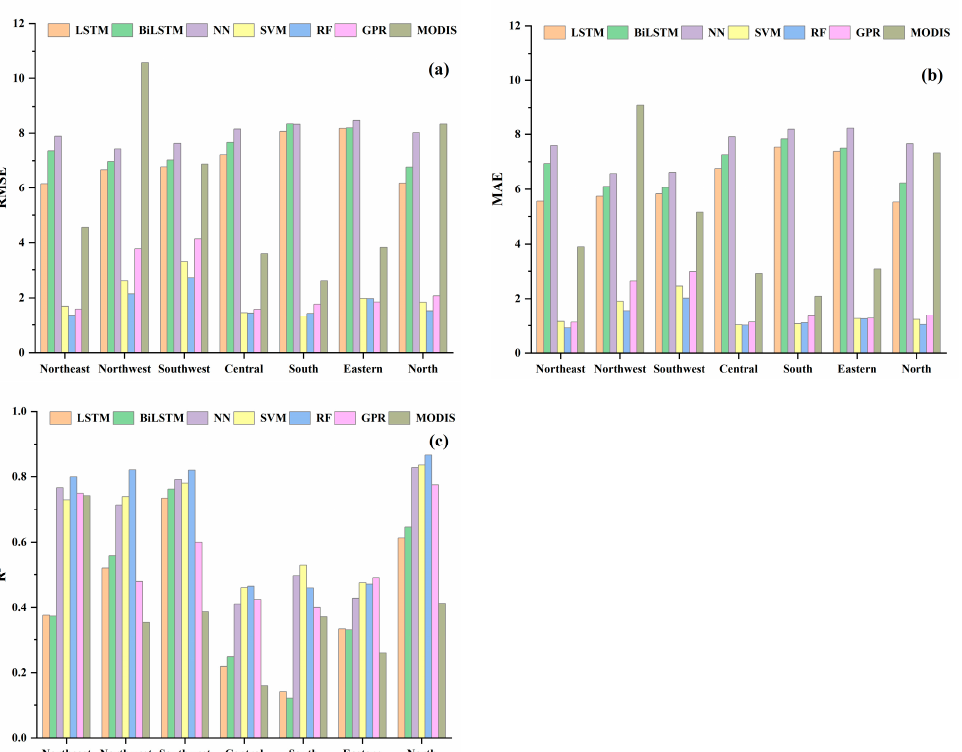
Figure 14. ( a ) RMSE mean values for different regions. ( b ) MAE mean values for different regions. ( c ) R² mean values for different regions.